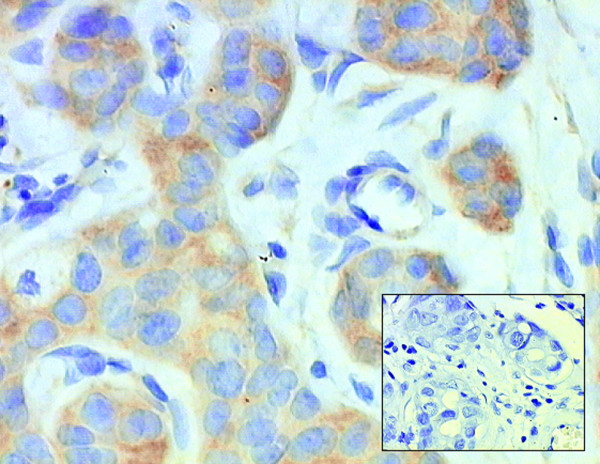
Immunohistochemical localization of cyclooxygenase-2 (red). The inset shows the control reaction with blocking peptide under the same conditions (hematoxylin, ×400).